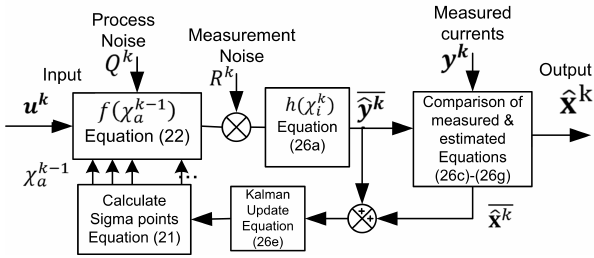
Figure 3. UKF nonlinear modeling for